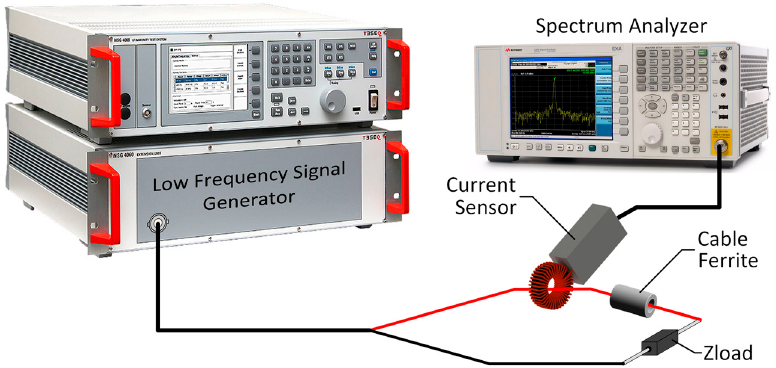
Figure 9. Measurement setup diagram to characterize cable ferrites in the 2–150 kHz frequency range.